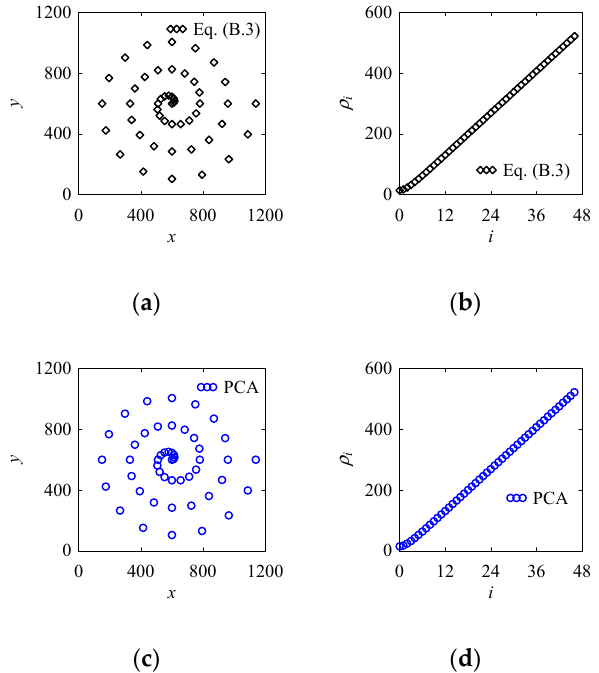
Figure 13. Spiral shapes and their radii of curvature. ( a ) Point cloud of a spiral modeled by a parametric equation; ( b ) radius of curvature of ( a ); ( c ) point cloud of a spiral modeled by the PCA; ( d ) radius of curvature of ( c ).